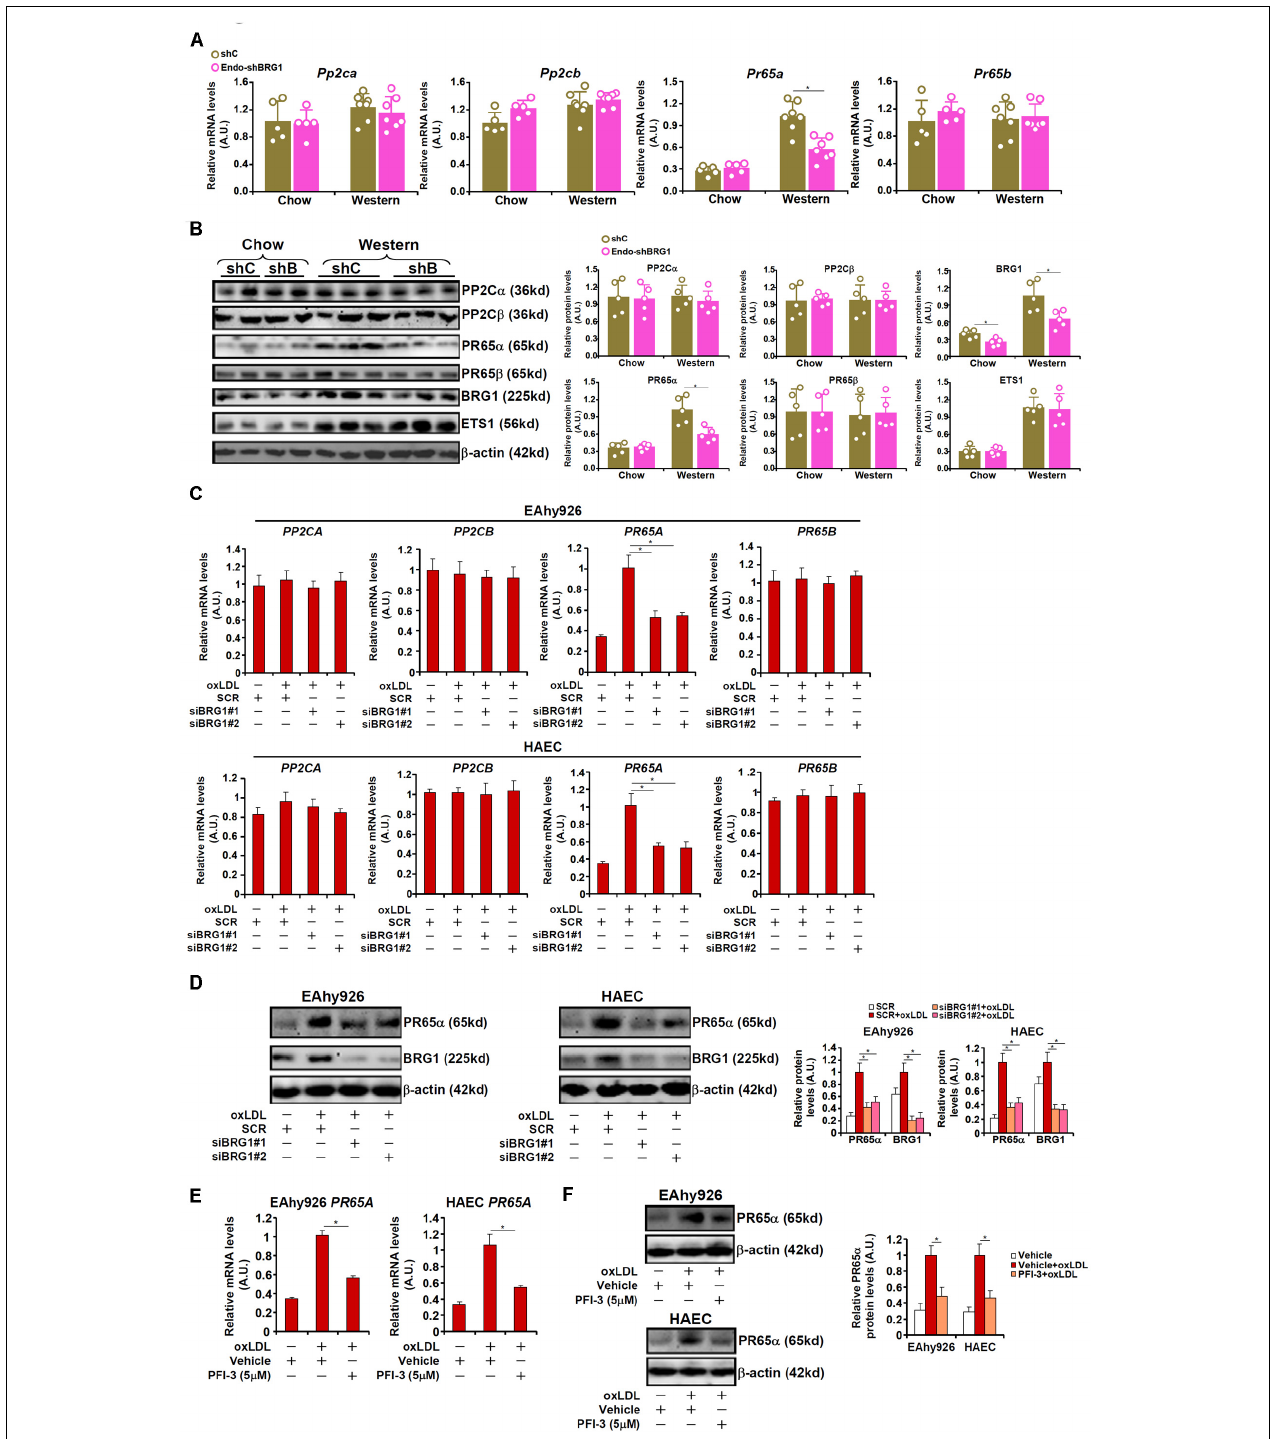
FIGURE 3 | BRG1 mediates PP2A transcription. (A,B) 8-week male Apoe − / − mice were injected with lentivirus carrying endothelial-specific BRG1 shRNA (Endo-shBRG1) or the control virus (shC) and fed a Western diet or a control diet for 8 weeks as described in “Materials and Methods”. Expression levels of specific genes in the aortic arteries were examined by qPCR and Western. N = 5 mice for the control diet groups and N = 7 mice for the Western diet groups. (C,D) EAhy926 cells and HAECs were transfected with siRNA targeting BRG1 or scrambled siRNA (SCR) followed by treatment with oxLDL (10 µ g/ml) for 24 h. Gene expression levels were examined by qPCR and Western. (E,F) EAhy926 cells and HAECs were treated with oxLDL (10 µ g/ml) in the presence or absence of PFI-3 (5 µ M) for 24 h. Gene expression levels were examined by qPCR and Western. * p < 0.05.